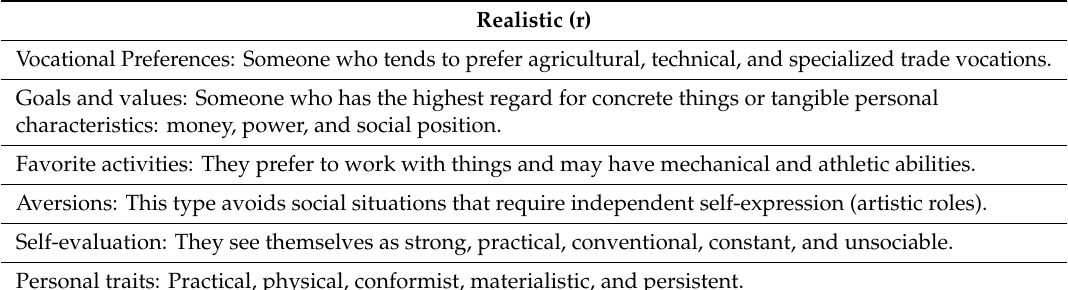
Table 2. Characteristics defining the Realistic vocational